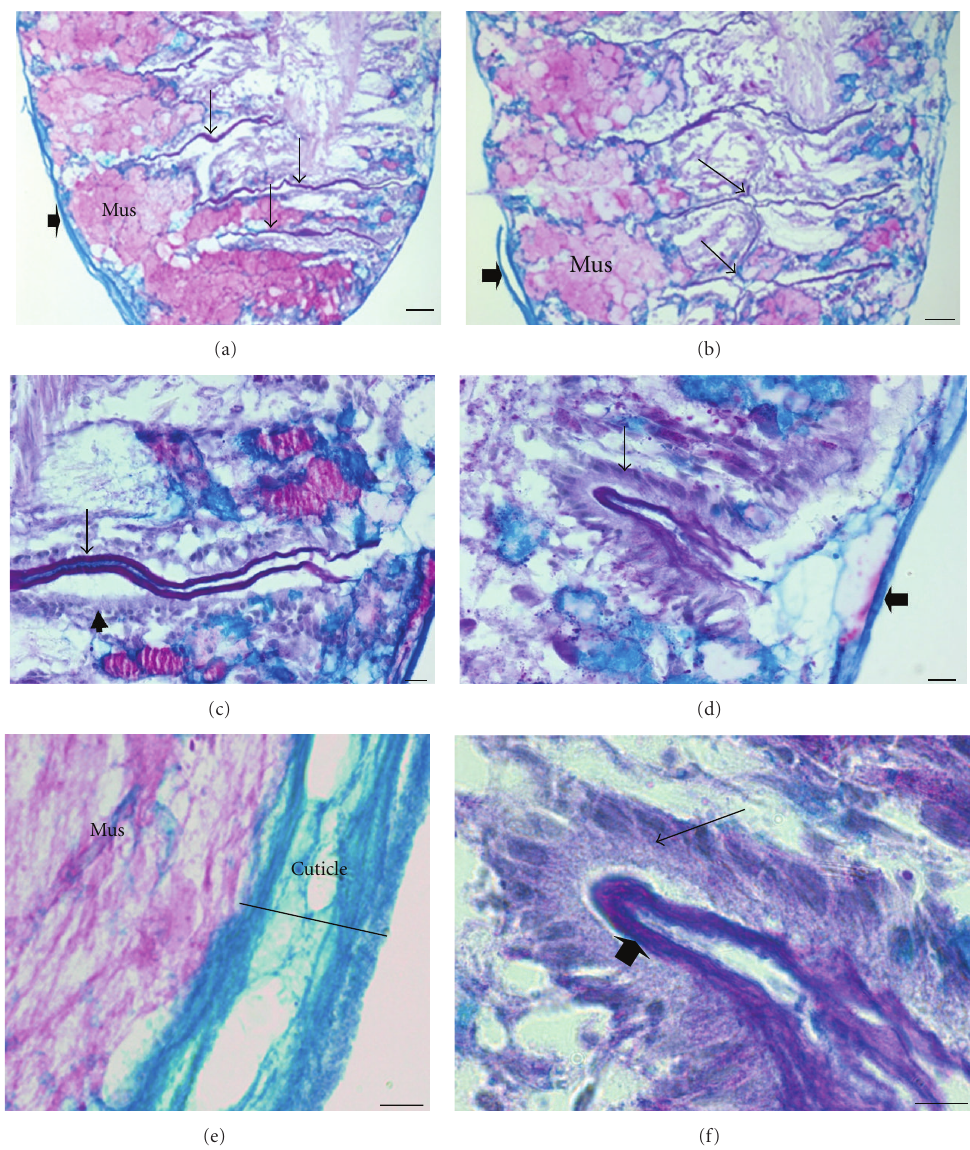
Figure 3: Alcian blue (pH 2.5)/PAS staining of longitudinal sections cut through the body wall showing segmental muscle blocks (mus) with detail of adjacent mucus channels. (a) Low magnification of a histological section through the worm showing latero-lateral orientation of mucus channels (thin arrows). Note also the strong Alcian blue (pH 2.5) reaction in the cuticle (arrowhead) (Scale bar = 5 µ m). (b) Low magnification of a histological section through the worm showing anterior/posterior orientation of channels perpendicular to laterals. Note presence of collection sinuses at channel intersections (thin arrows). The cuticle again stained strongly with Alcian blue (arrowhead) (Scale bar = 5 µ m). (c) High magnification of lateral mucus channel showing intense staining of secretion with Alcian blue (pH 2.5)/PAS (large arrow). Note lightly stained secretory cells with basal nuclei lining the channel (arrowhead) (Scale bar = 1 µ m). (d) High magnification of lateral mucus channel opening toward the integumental surface. Note secretory cells with basal nuclei (small arrow) and deeply stained mucoid secretion (large arrow). The cuticle is indicated by the arrowhead (Scale bar = 1 µ m). (e) High magnification of outer cuticle adjacent to a muscle block (Mus) showing strong Alcian blue reactivity in the region (Scale bar = 1 µ m). (f) Detail of glandular structure showing secretory cells exhibiting basal nucleus and granular apical cytoplasm (large arrow). Note viscous secretion associated with the luminal surface (arrowhead). (Scale bar = 1 µ